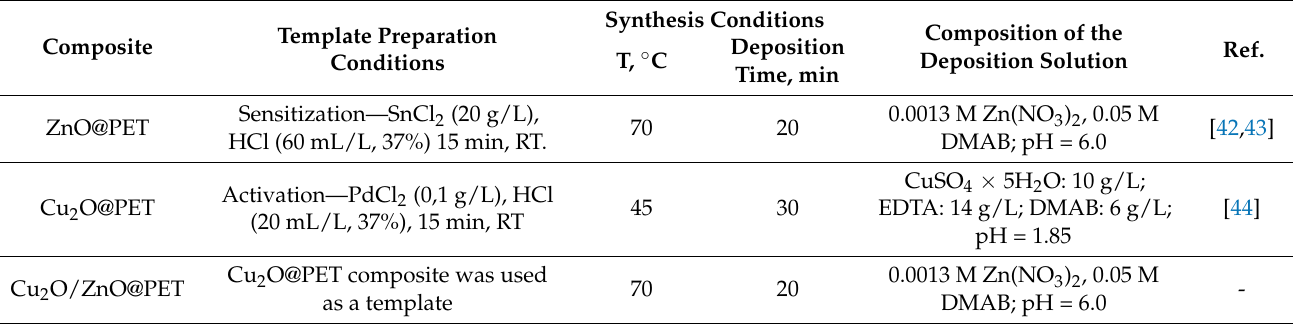
Table 1. Synthesis conditions of composite